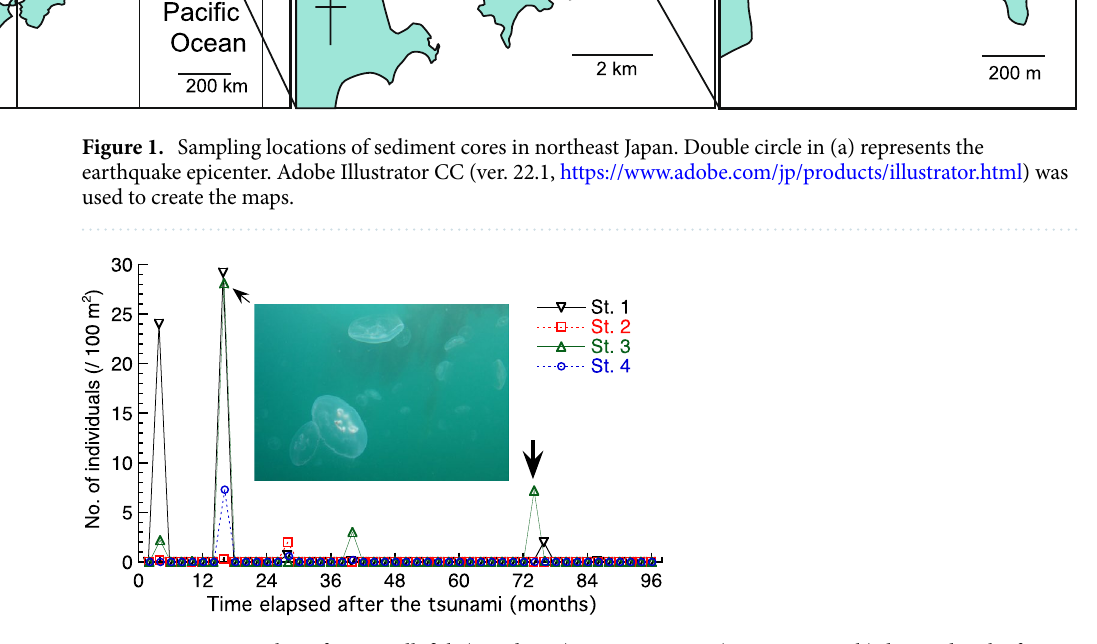
Figure 2. Mean number of moon jellyfish ( Aurelia sp.) in ten transects (2 m × 50 m each) detected at the four stations in and around Moune Bay, Kesennuma, in the visual surveys over the eight years after the 2011 tsunami (Masuda et al. 29 with updated data). Station numbers correspond with those in Fig. 1. Inserted picture was taken on July 2012 at St. 3. The thick arrow represents the timing of sediment core collection in the present